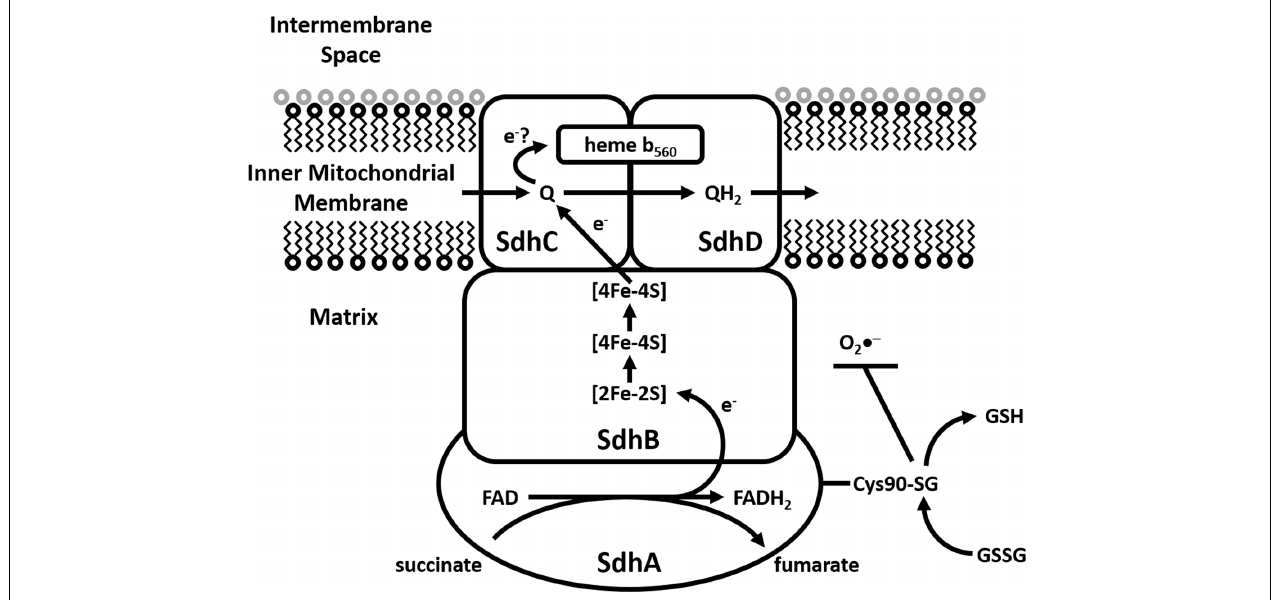
FIGURE 4 | Modulation of Sdh by S-glutathionylation. Representative diagram illustrating electron flow from succinate to ubiquinone in Sdh with subsequent production of fumarate. The S-glutathionylation of Cys 90 on SdhA subunit is required to maintain succinate oxidation